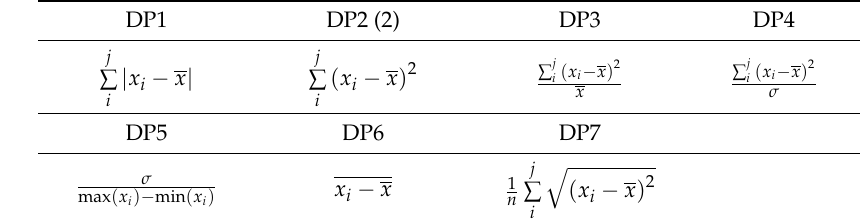
Table 1. Various scoring functions for our implementation of dynamic programming (DP), where σ denotes a standard deviation, x is a mean value and n is a number of points in segment.